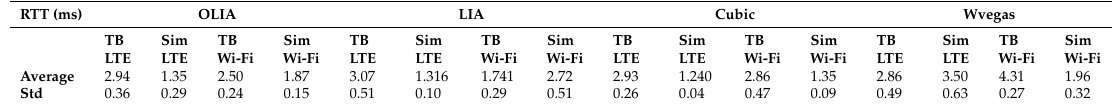
Table 4. Setup 1 uplink RTT for 75 MB flows.